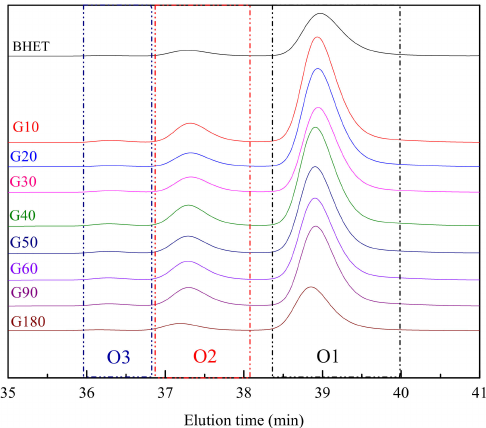
Figure 3. GPC traces for reaction products obtained at different times, together with that of BHET. Table 3. Oligomer content (%) and M w and M n values as obtained by GPC.